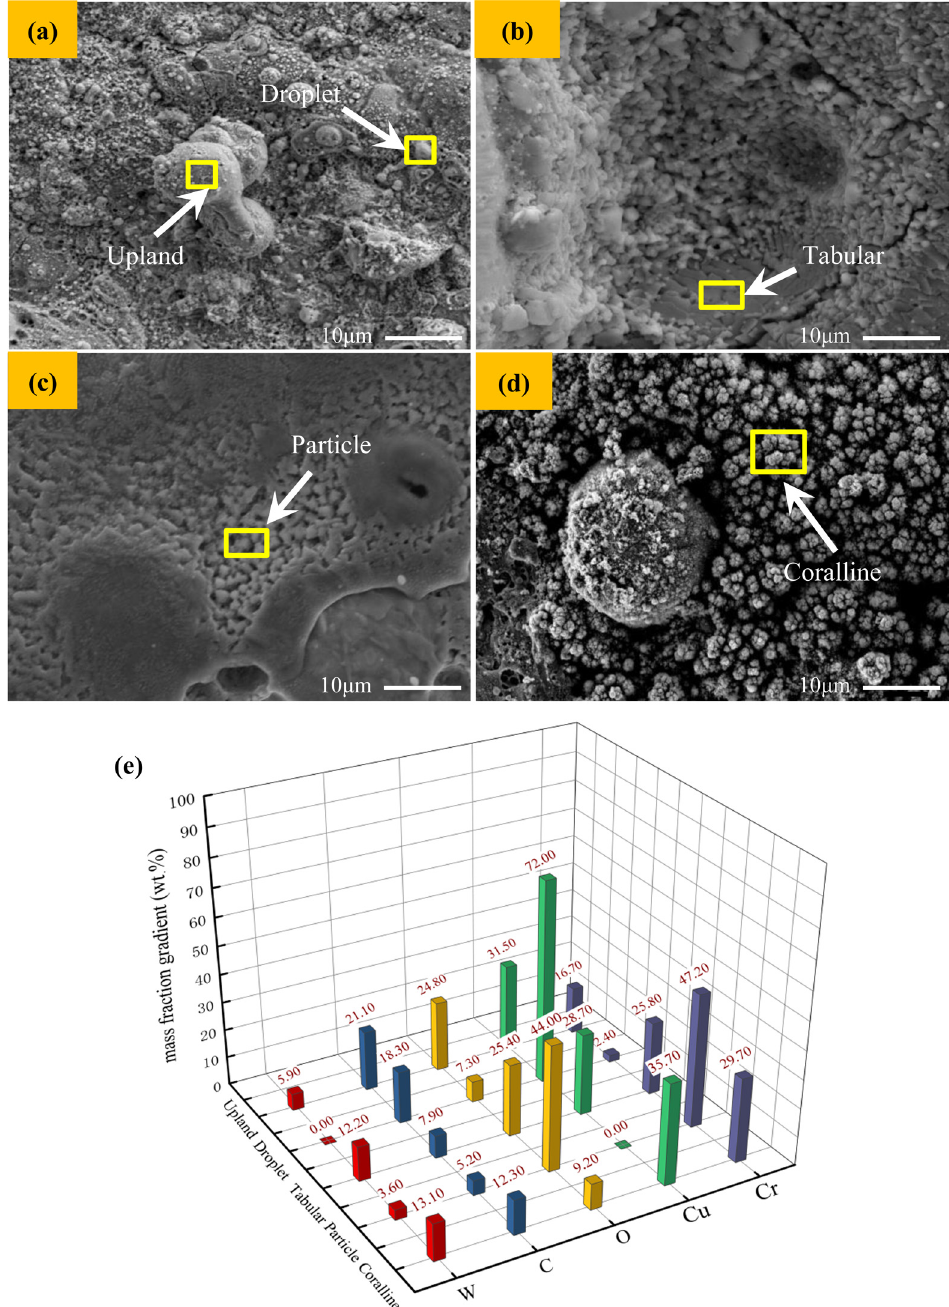
Figure 8: SEM image and EDS analysis of typical characteristics of electrical contact: ( a ) droplet and upland; ( b ) tabular; ( c ) particle; ( d ) coralline; ( e ) EDS